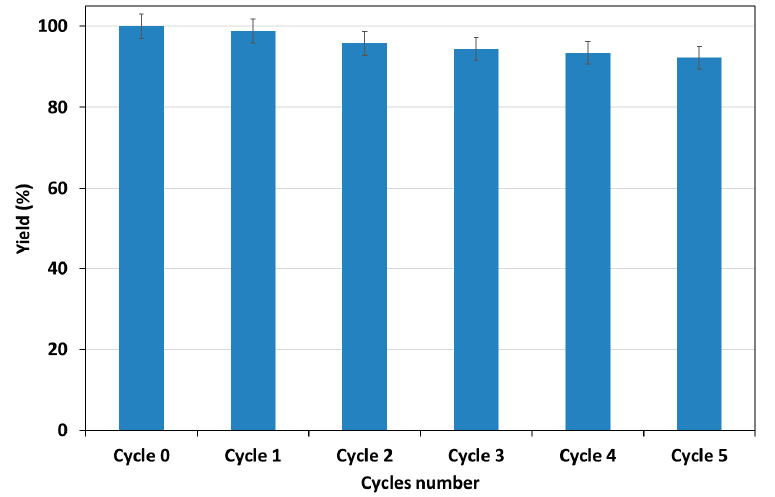
Figure 11. Discoloration percentage of methylene blue after five consecutive uses of the same pho- tocatalyst (C 0, MB = 60 mg/L, C 0, Zn2+ = 60 mg/L pH neutral, D TiO2 = 1 g/L; temperature = 20 ± 2